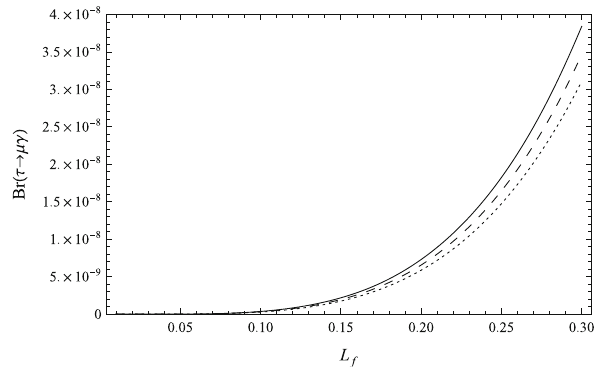
Fig. 13 With Y e 4 = 0 . 5 ( 1 . 0 , 1 . 5 ) , the branching ratios of τ → μγ versus parameter L f are plotted by the dotted, dashed and solid lines respectively